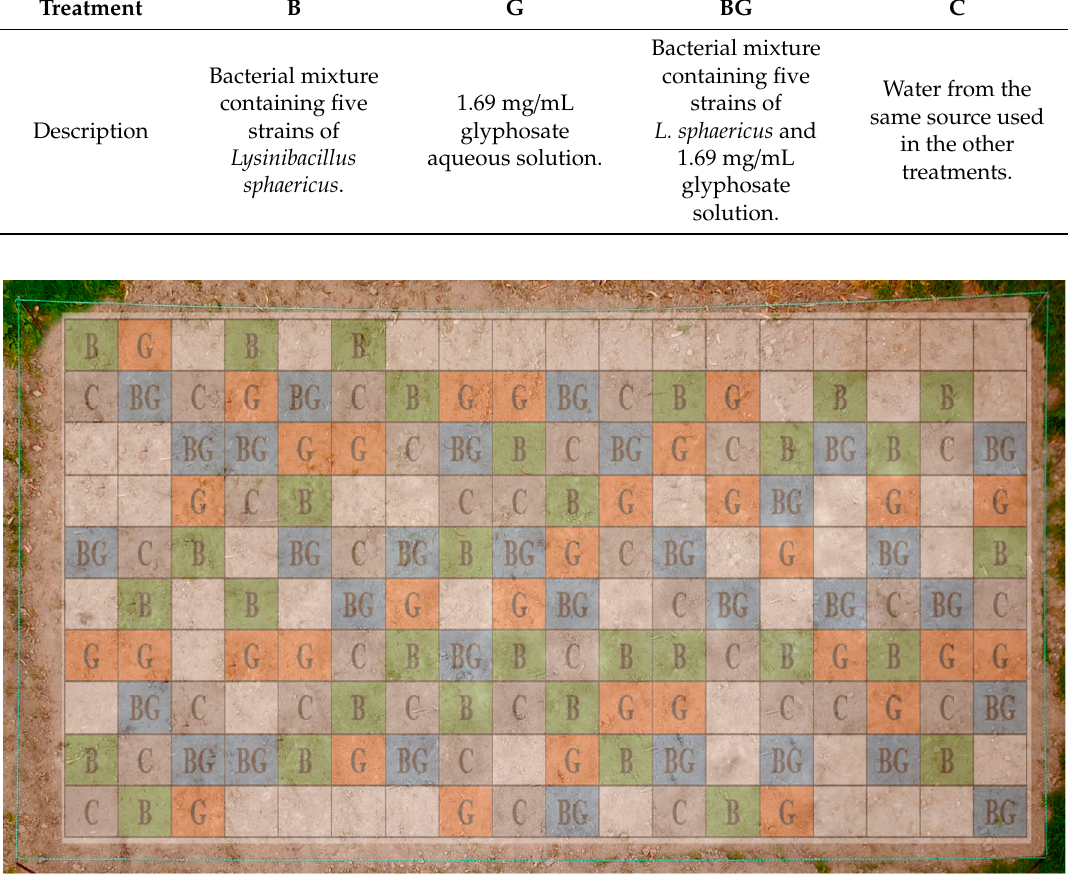
Figure 3. Potato crop treatment distribution in Gachancipá, Cundinamarca. A parcel was subdivided as to receive four different treatments. B : bacteria, G: glyphosate, BG : glyphosate + bacteria, C : negative control.